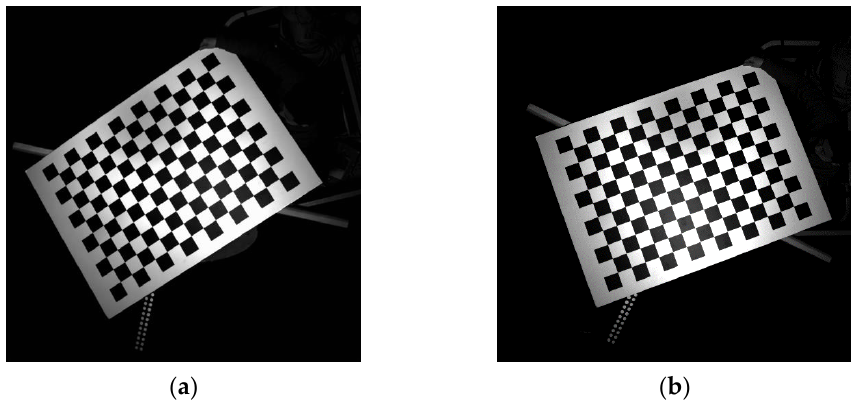
Figure 7. Examples of calibration images taken by ( a ) camera 1 and ( b ) camera